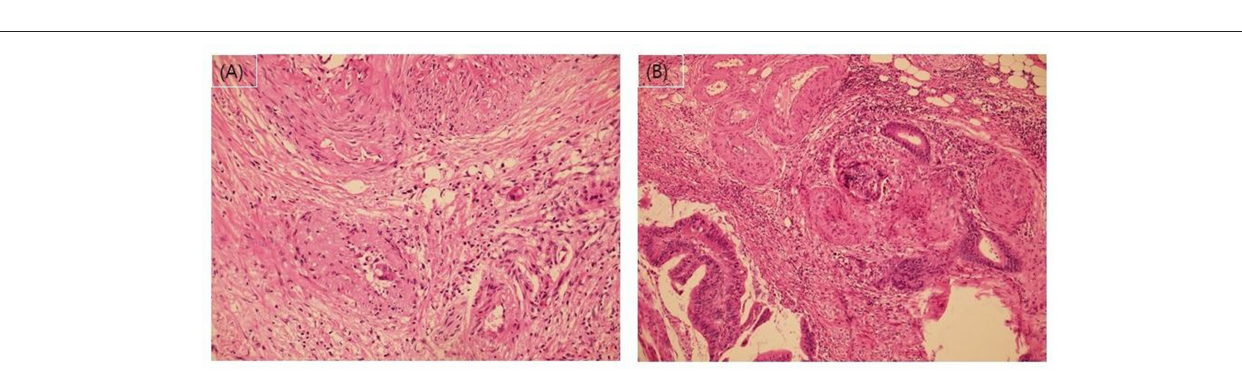
FIGURE 1 | Study flow chart. VI, vascular invasion; LNM, lymph node metastasis.